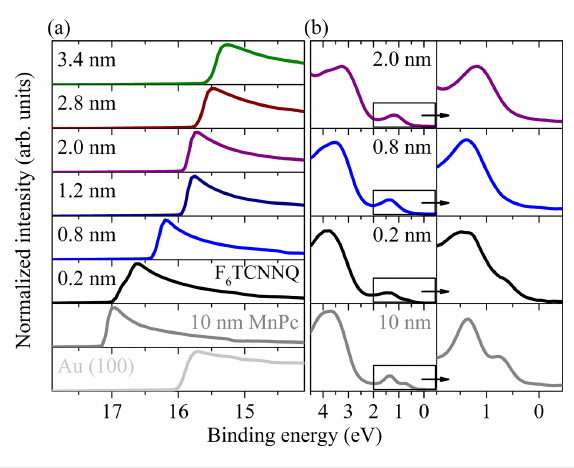
Figure 11: Valence-band photoemission data from the MnPc/ F 6 TCNNQ interface as a function of the F 6 TCNNQ top-layer thickness. Panel (a) shows the evolution of the secondary electron cutoff, which represents the changes of the work function. Panel (b) focusses on the energy region close to the Fermi